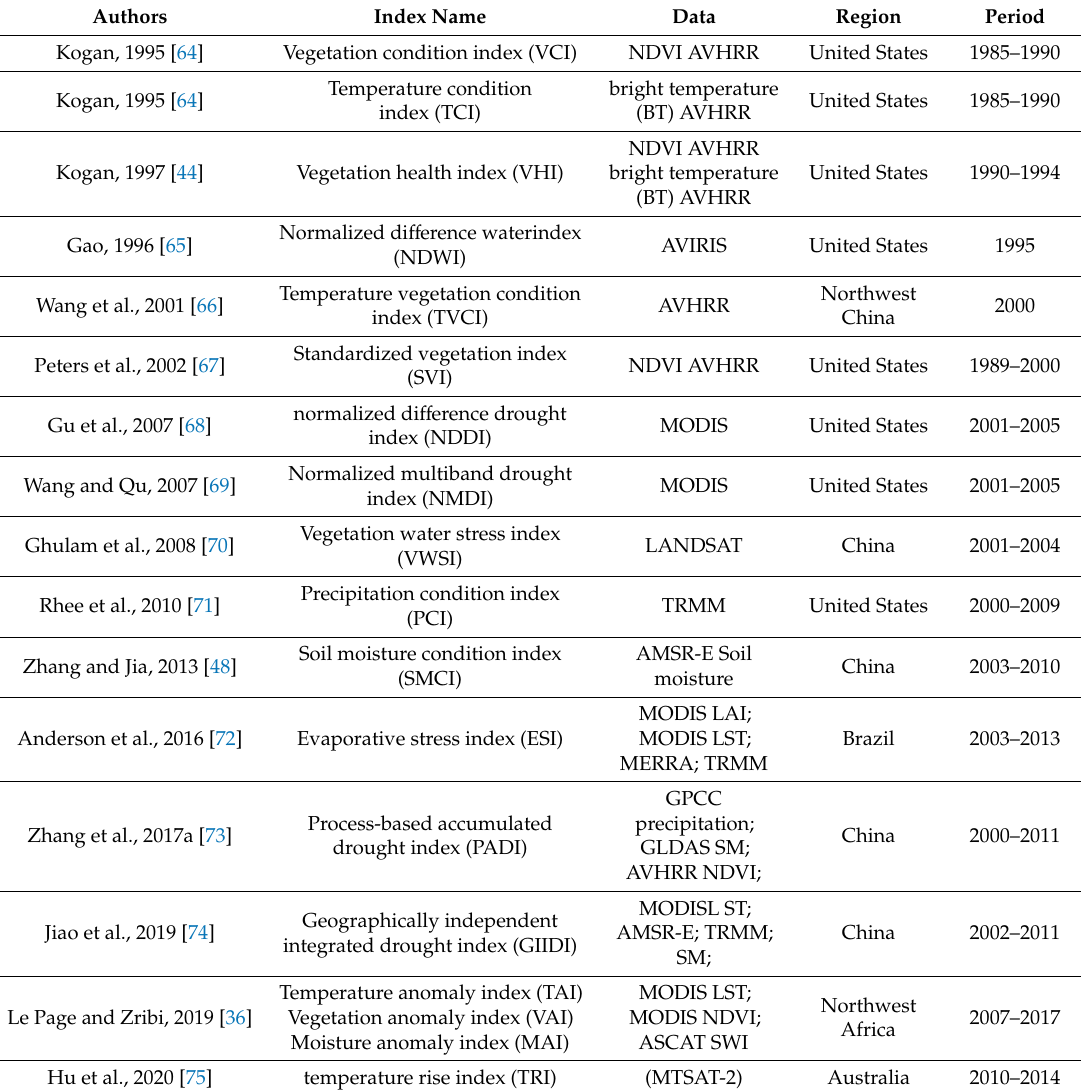
Table 1. Summary of remote sensing drought